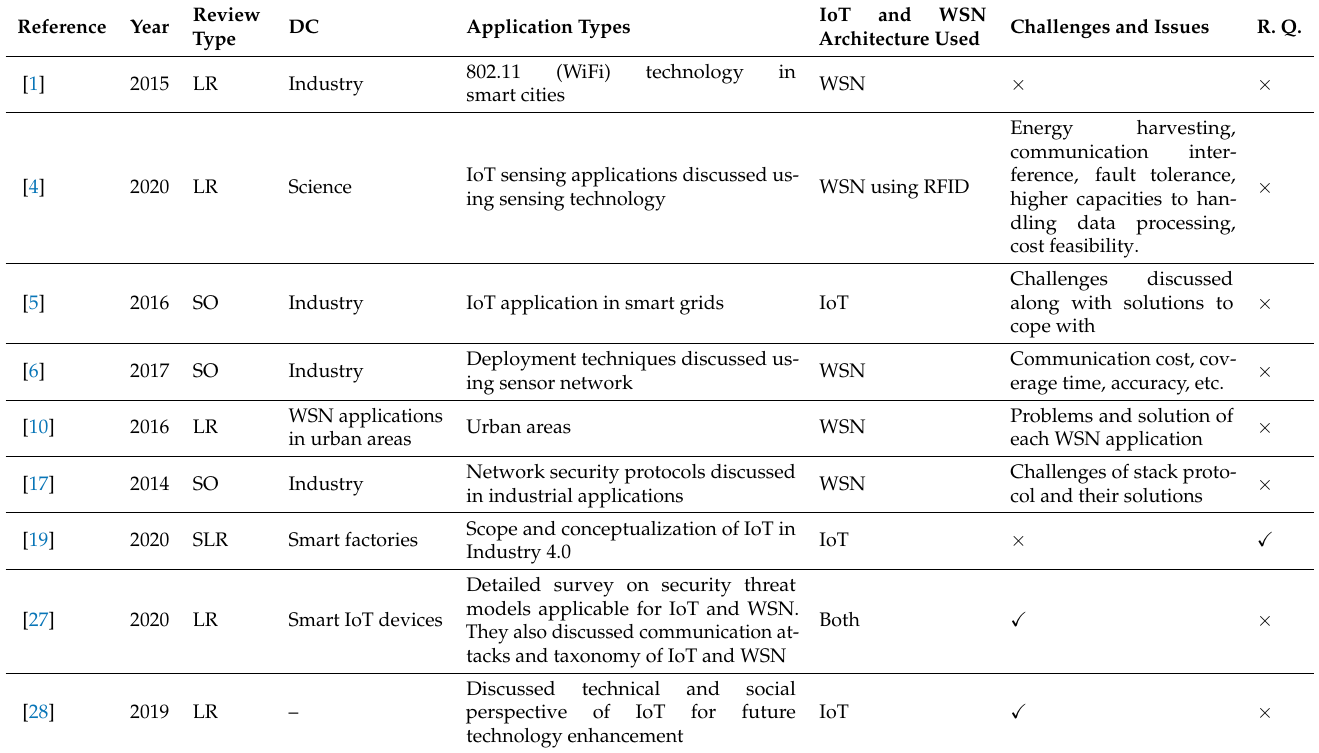
Table 2. Comparative analysis of the existing review papers. Key: deployment category—DC, literature review—LR, security overview—SO, bibliometric literature review—BLR, systematic litera- ture